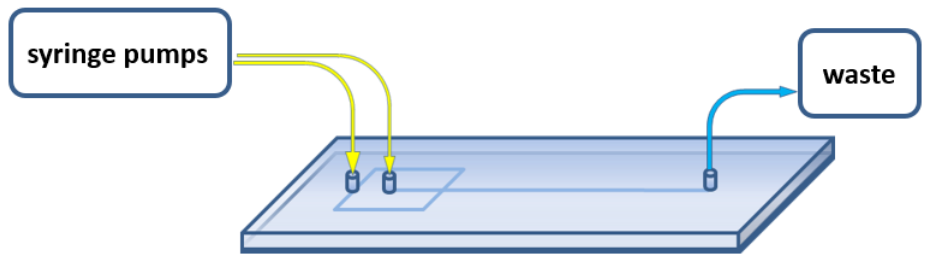
Figure 1. The experimental setup comprises the needed amount of syringe pumps, the polycarbonate chip, and a waste container. In the optimal conditions, the microchannels are modified with the use of 20% NH 4 OH for 2 h with flow rate equals 6 mL h − 1 and then are rinsed with water for 30 min with the same flow rate.